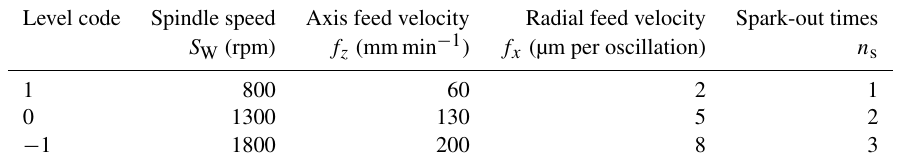
Table 3. Box–Behnken level of the IGPH experiment.